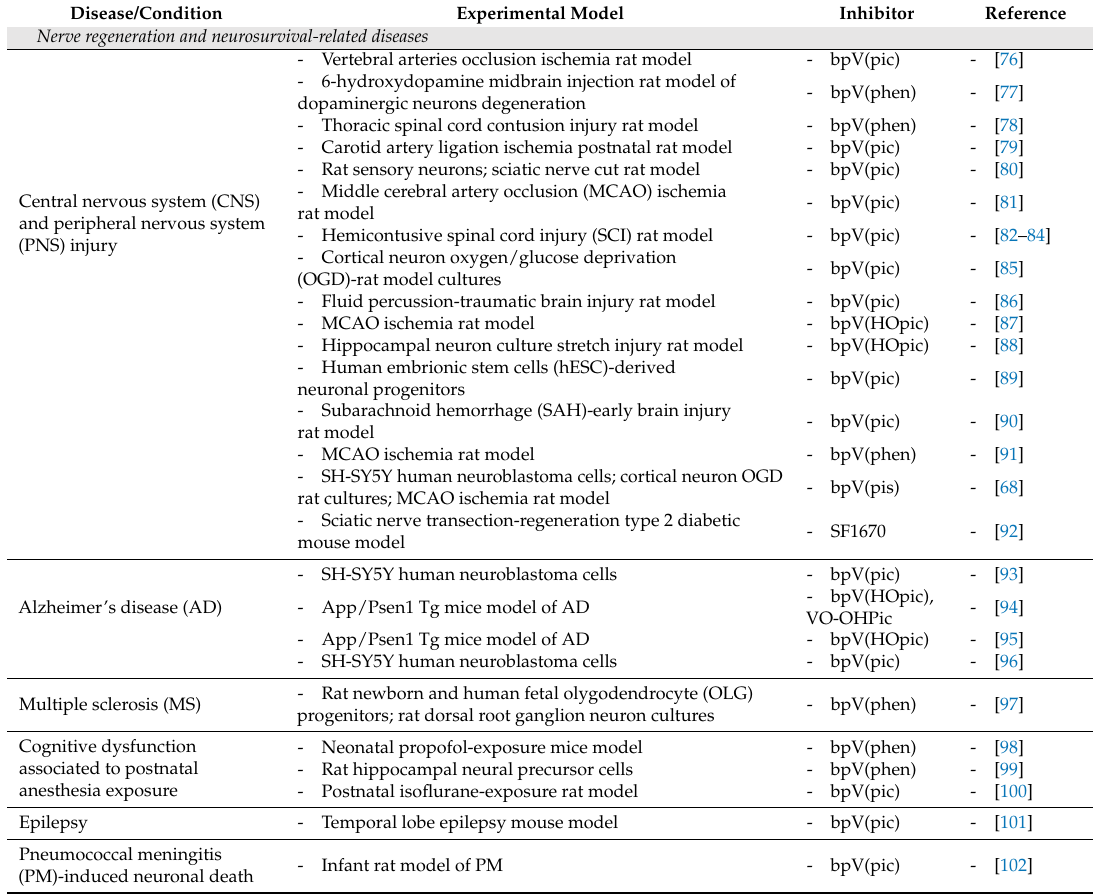
Table 3. Selected studies using small molecule PTEN inhibitors with potential therapeutic